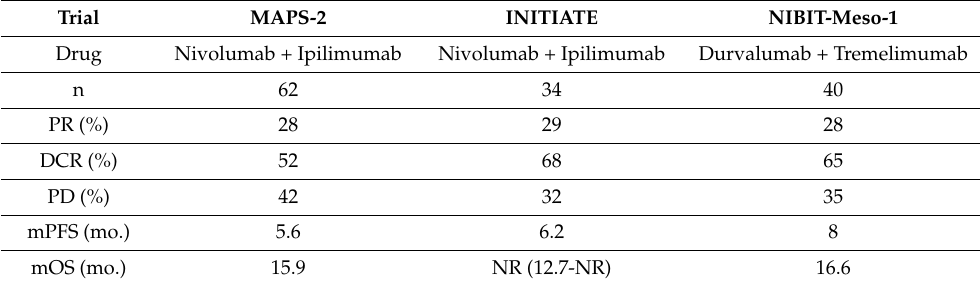
Table 2. Selected phase 2 trials with immunotherapy combinations in salvage